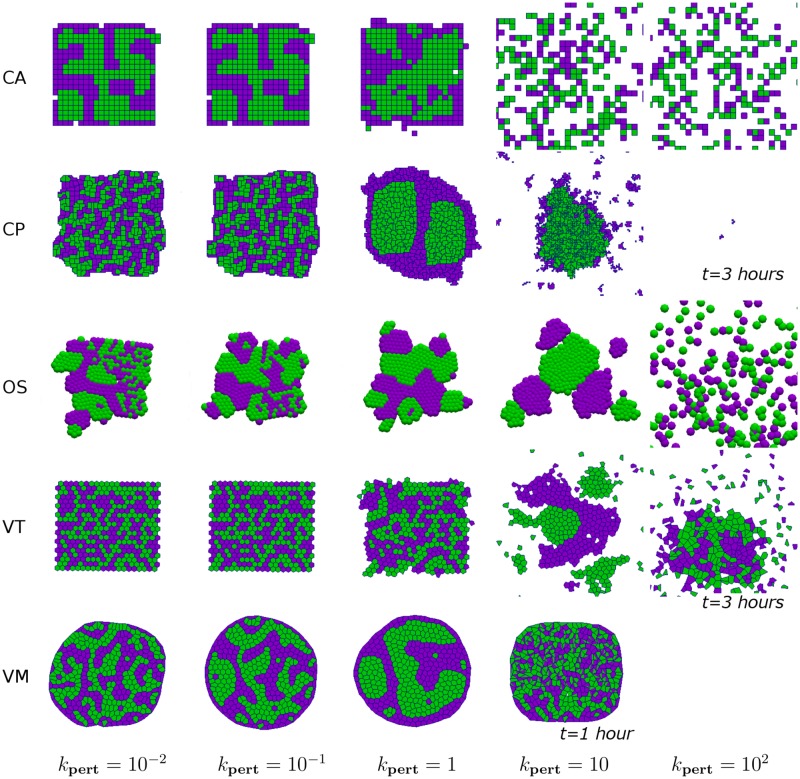
Effect of perturbations on cell sorting.Snapshots at t = 100 (unless otherwise indicated) for the simulations presented in Fig 2 for varying kpert = 10−2, 10−1, 1, 10, 102. Parameter values are given in Tables 1 and 2. For CP simulations with kpert = 102 a snapshot is given at t = 3 as by this time in the simulation cells are already dissociated and have left the viewing window. For VT simulations with kpert = 102 a snapshot is given at t = 3 as by this time in the simulation a cell has left the tissue domain and caused an infinite Voronoi region and the simulation is halted. For VM simulations with kpert = 101 a snapshot is given at t = 1 as by this time in the simulation the perturbations cause cells to become inverted and the simulation is halted. There is no plot for VM simulations with kpert = 102 as for this level of perturbation cells become inverted at the first time step so the simulations are not run. Note the central column corresponds to the t = 100 snapshots in Fig 2.